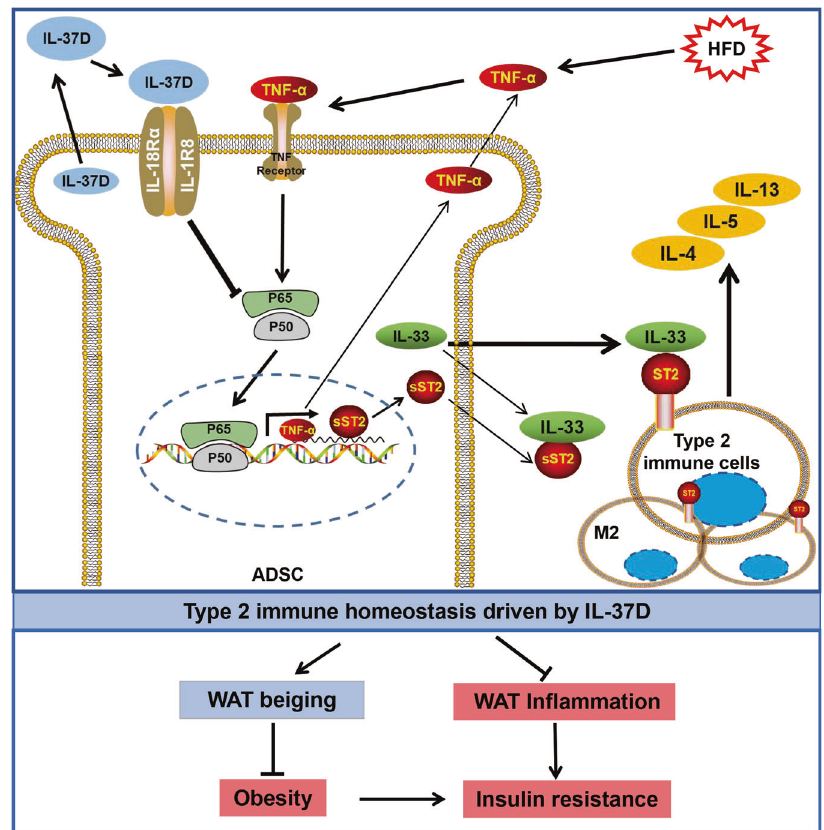
Fig. 8 Working model for IL-37D-mediated sST2 inhibition in promoting WAT type 2 immune homeostasis. IL-37D inhibits sST2 production from ADSCs through IL-1R8-dependent NF- κ B inactivation, which promotes IL-33/ST2 signaling to boost type 2 immune homeostasis in WAT characterized by ampli fi cation of ST2 + type immune cells and increase of type 2 cytokines, thereby providing protection against diet-induced obesity and insulin resistance through WAT beiging and in fl ammation